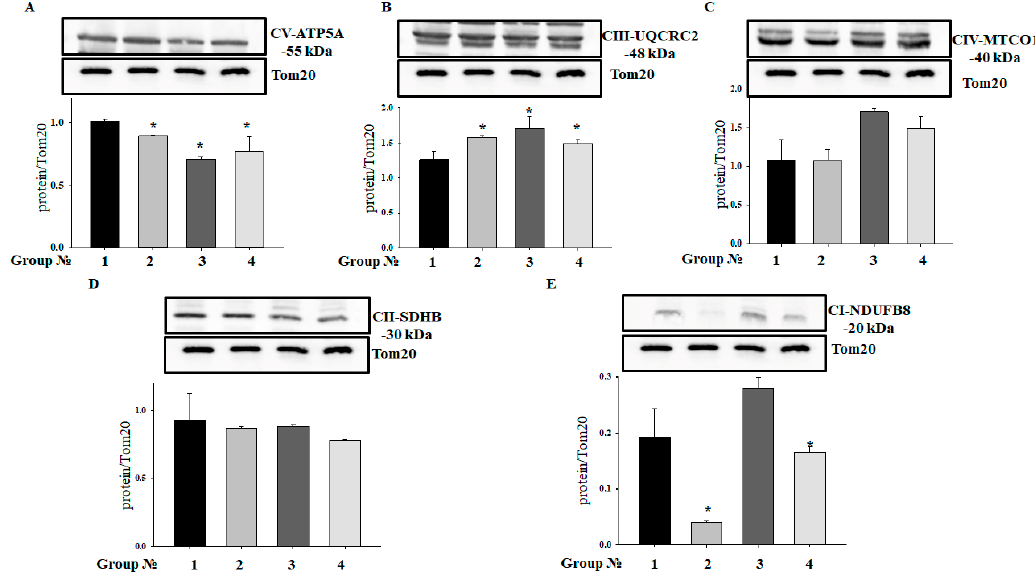
Figure 3. Alterations in mitochondrial respiratory chain complexes in RHM. Protein samples were extracted and subjected to Western blotting. Changes in mitochondrial complexes were detected using the Total OXPHOS Rodent WB Antibody Cocktail. ( A ): changes in complex V alpha subunit (CV-ATP5A-55 kDa), ( B ): complex III core protein 2 (CIII-UQCRC2-48 kDa), ( C ): complex IV subunit I (CIV-MTCO1-40 kDa), ( D ): complex II subunit 30 (CII-SDHB-30 kDa), ( E ): complex I subunit NDUF88-20 kDa (CI-NDUFB8). Immunodetection of Tom20 was used as a loading control. The upper parts of panels represent immunostaining with an OXPHOS antibody cocktail and Tom20. The lower parts show the quantification of immunostaining using computer-assisted densitometry. Bar graphs represent the levels of appropriate complexes with respect to the Tom20 level in absolute units. The data are presented as the means ± SD. * p < 0.05 significant difference in the protein level in comparison with the corresponding control.